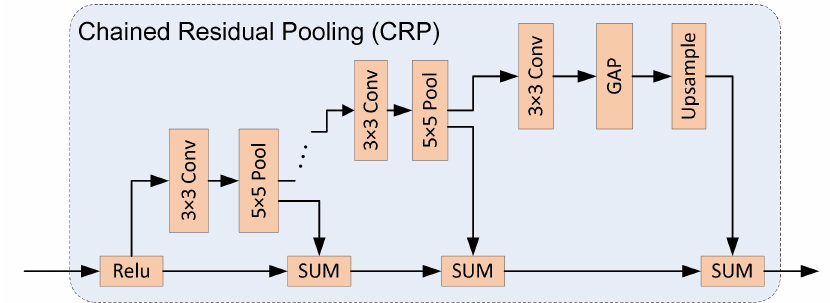
Figure 9. The structure of the Chained Residual Pooling